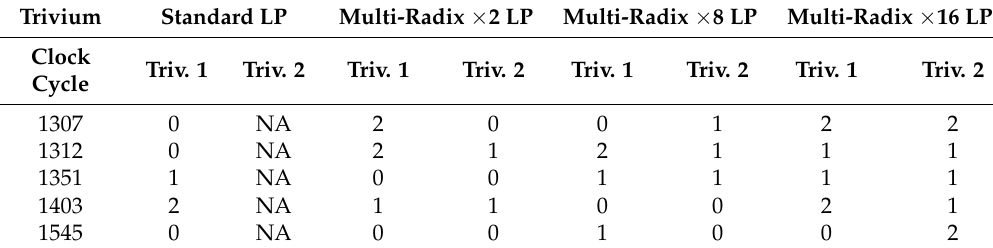
Table 7. Number of faults injected into each pair of low-power Trivium cipher versions in different clock cycles.